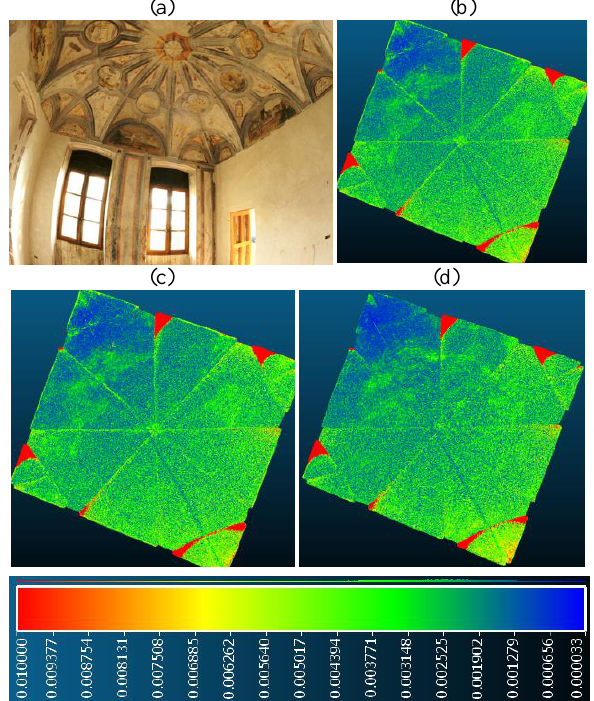
Figure 7. An image of the vault (a) and comparison between laser and image-based point clouds for the different software: (b) PhotoScan, (c) Pix4D, (d)